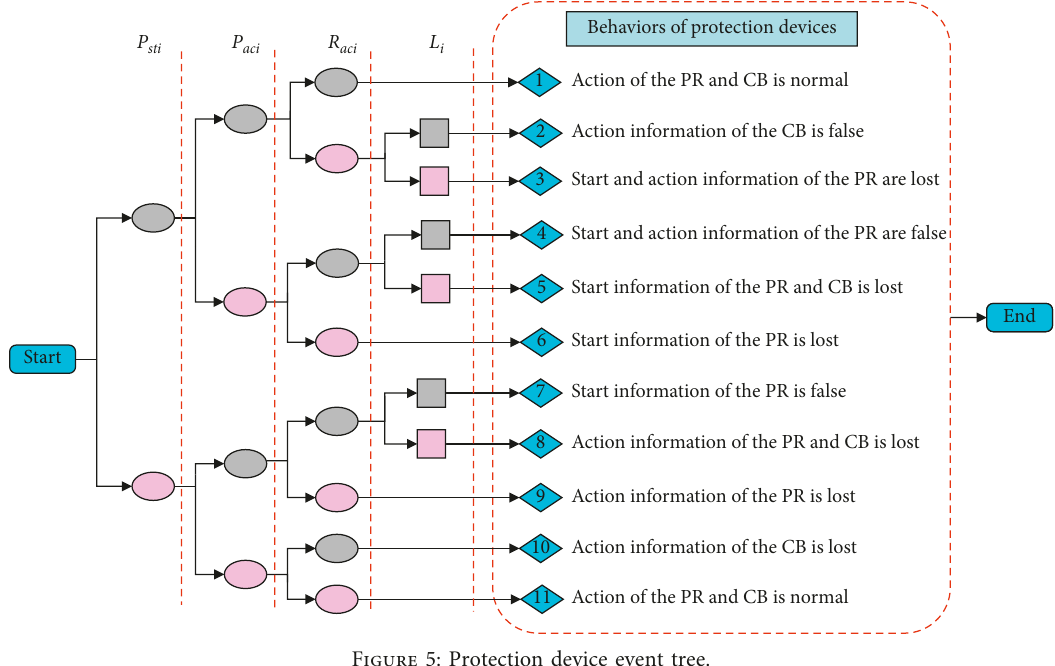
Figure 5: Protection device event tree.